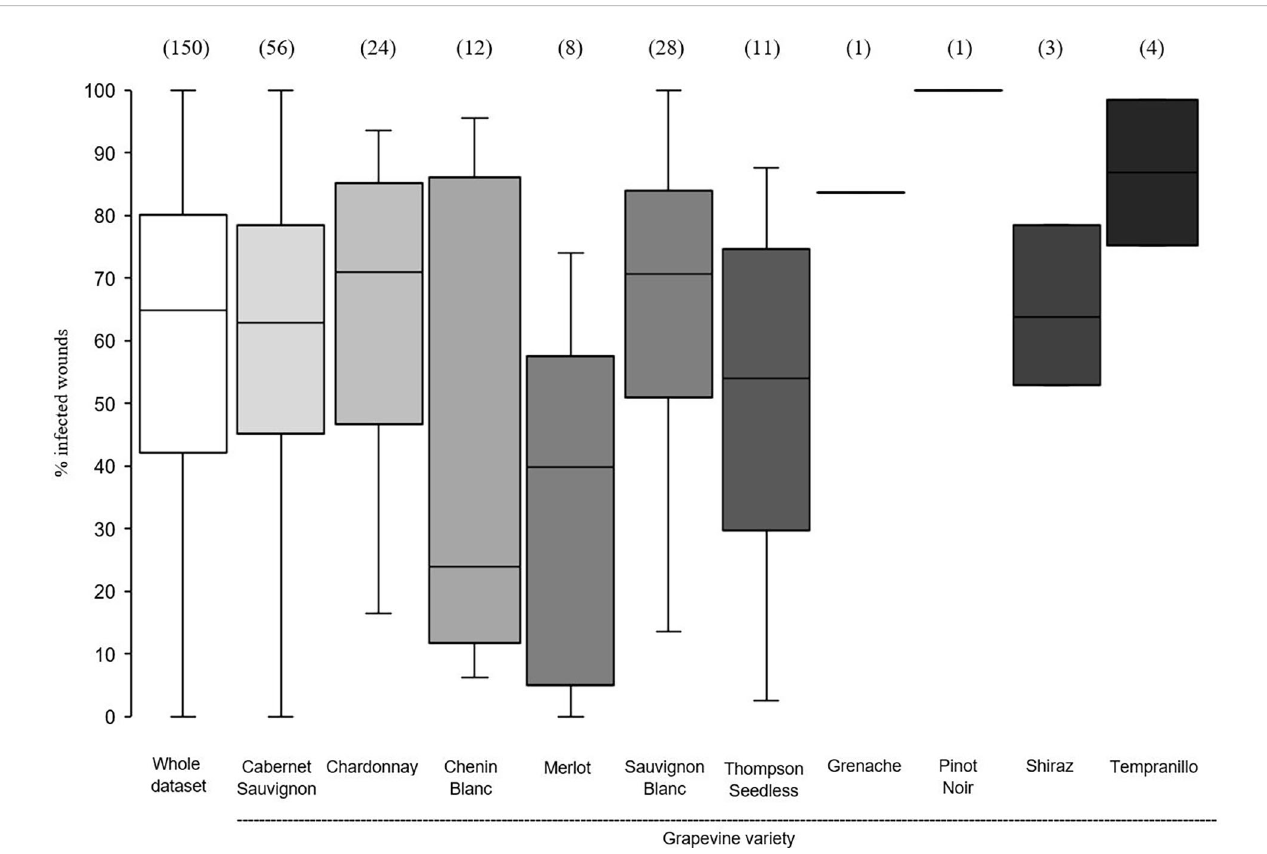
FIGURE 3 Susceptibility of the pruning wounds at the time of pruning (t 0 ) (expressed as the % of the wounds that became infected after being arti fi cially inoculated with fungi associated with grape trunk diseases [GTDs] for the whole data set (the white box) and for subsets of data concerning grapevine varieties. The values in brackets indicate the number of observations available for each subset. Whiskers indicate the lowest and highest values (excluding outliers, represented by black dots); 25% of the data fall below the lower quartile value, and 75% of the data fall below the upper quartile value. The median marks the mid-point of the data and is shown by the line that divides the box into two